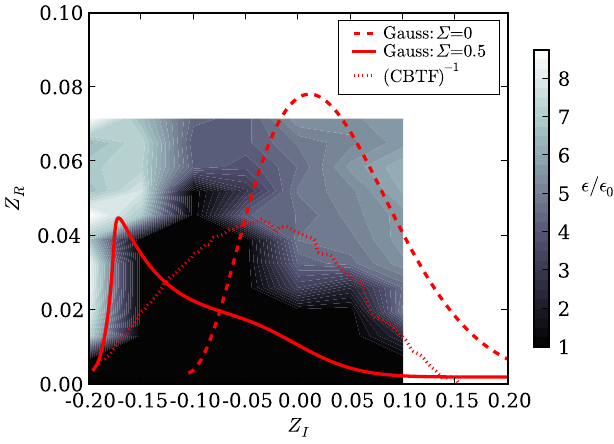
FIG. 12. (Color) Simulation scan of the stability boundary in the normalized impedance plane for a double rf wave and (cid:1) (cid:7) 0 : 5 . The bunch length of the initially matched Gaussian distribution (cid:7) 60 (cid:12) . The red curves represent the stability boundaries is (cid:1) m obtained from the dispersion relation equation (28) for (cid:1) (cid:7) 0 (dashed curve) and (cid:1) (cid:7) 0 : 5 (solid curve). The dotted red curve represents the stability boundary obtained from the CBTF (see Sec. VIII) for (cid:1) (cid:7) 0 : 5